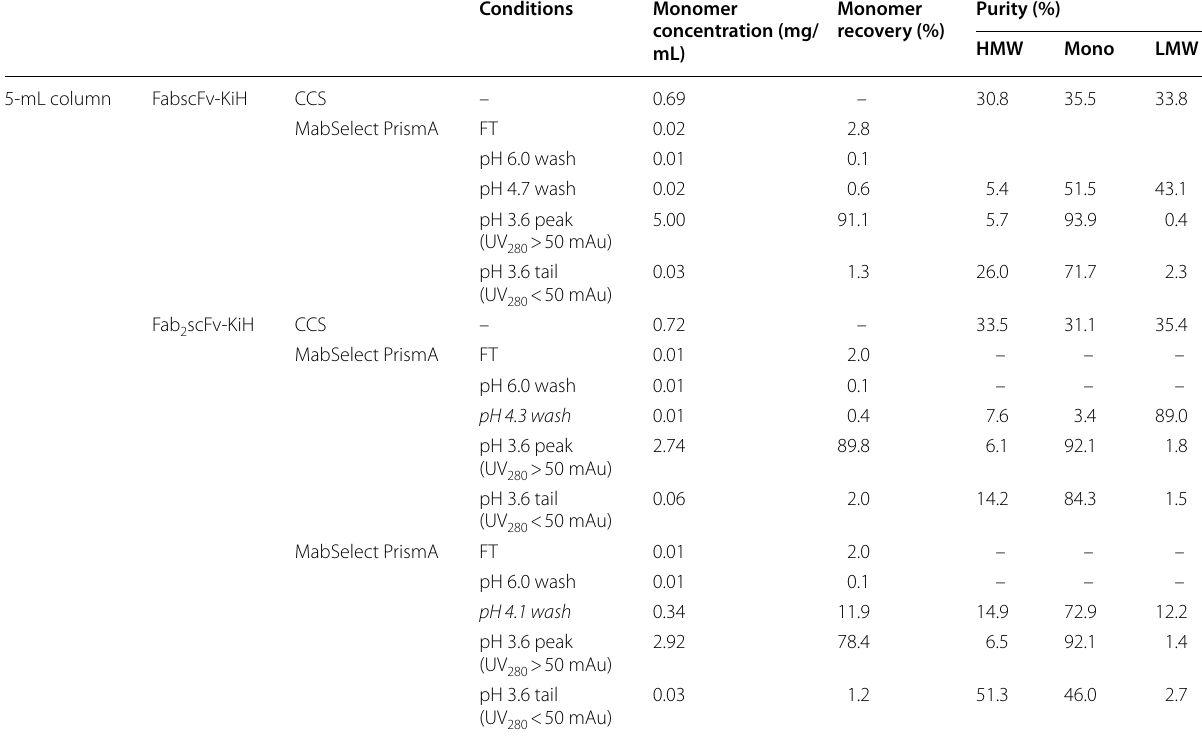
Monomer Purity (%) recovery (%) HMW Mono LMW